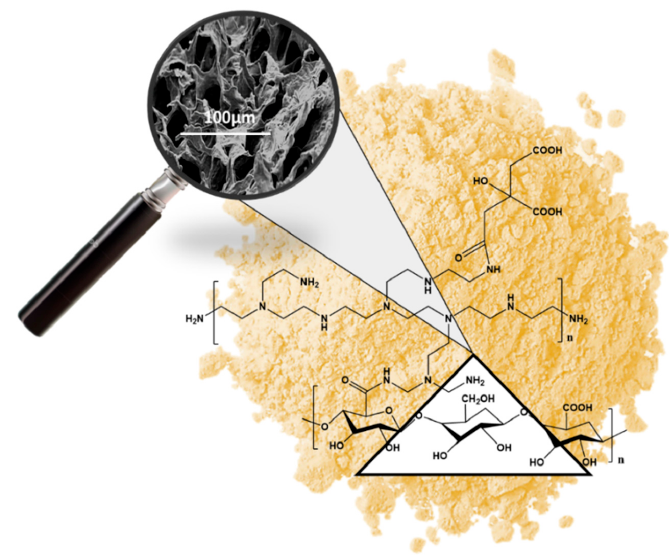
Figure 2. Inner structure of grinded CNS analyzed by Scanning Electron Microscopy.